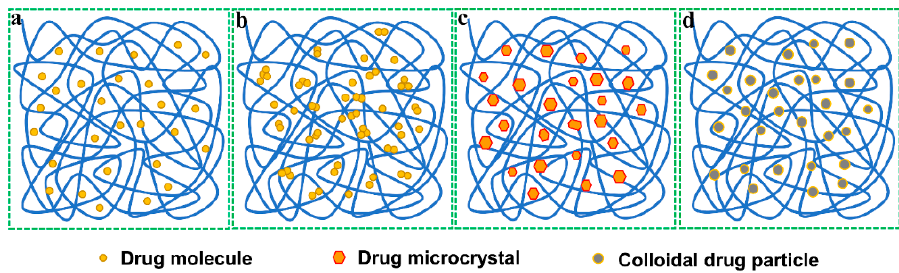
Figure 2. Physical state of drug in solid dispersions: ( a ) molecular state, forming solid solution; ( b ) amorphous state, forming amorphous dispersions; ( c ) microcrystal state, forming simple dispersions; ( d ) colloidal state, forming colloidal dispersions.